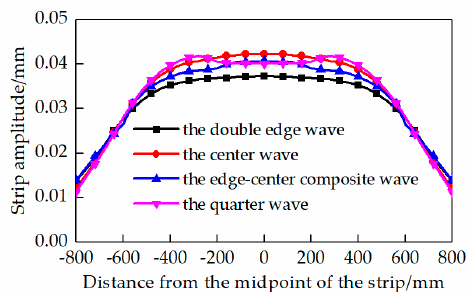
Figure 12. The strip amplitude distribution of different flatness defects .